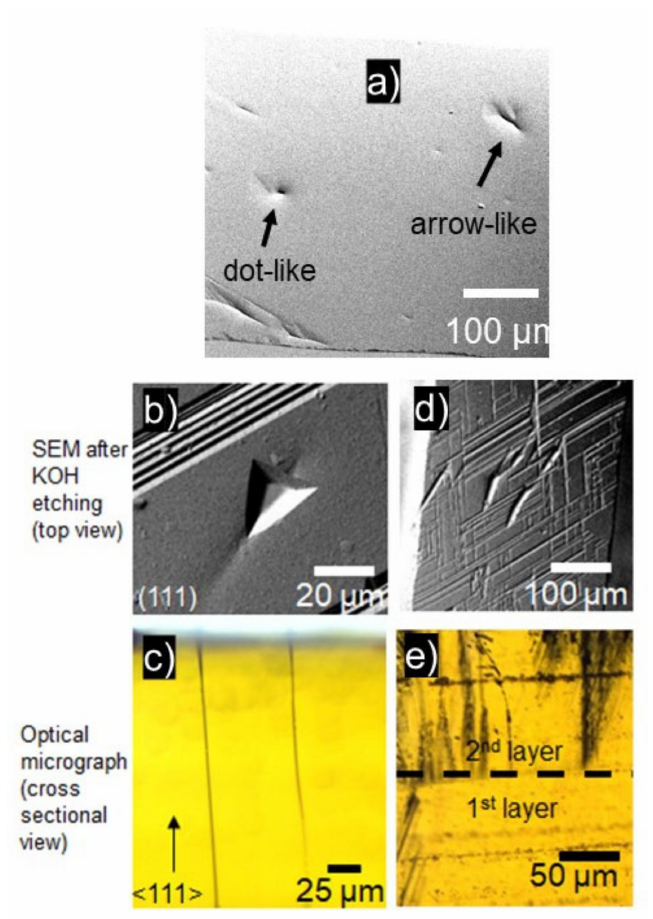
Figure 19. Top view SEM image after KOH etching of ( a ) threading dislocation and ( d ) arrow-like defects. Optical micrograph (cross-sectional view) of ( b ) threading dislocations and ( e ) arrow-like defects. ( c ) SEM image of the surface appearance of